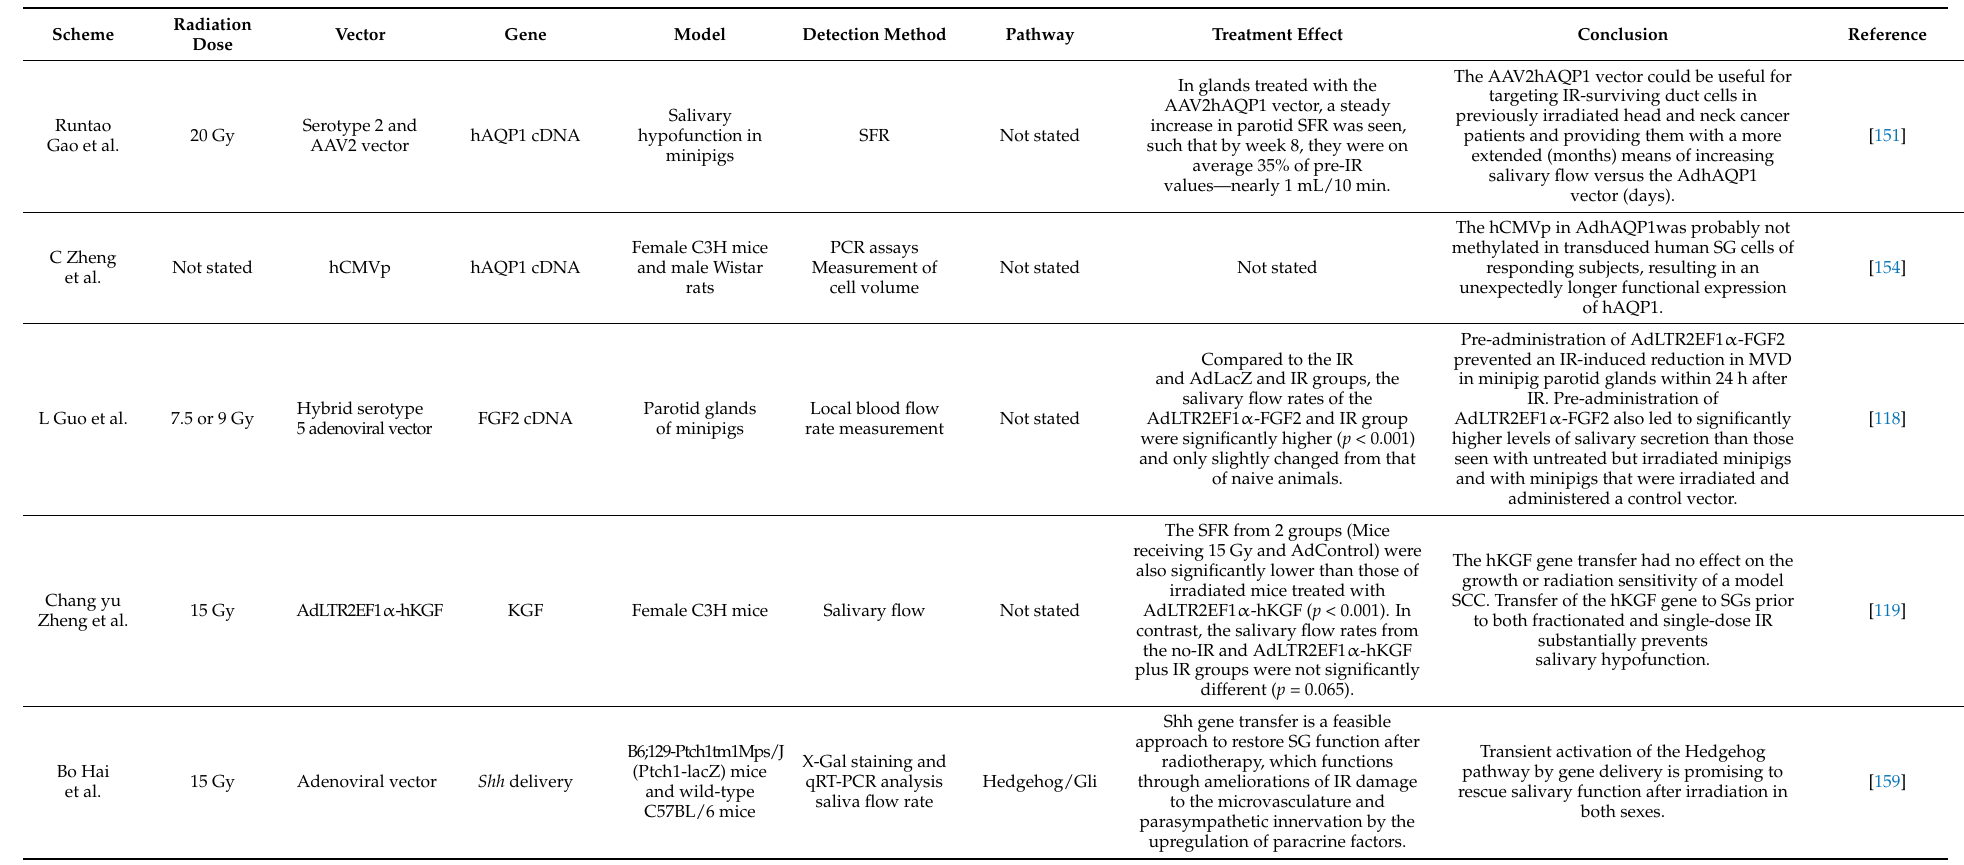
Table 3. Gene transfer treatment of radiation-induced SG